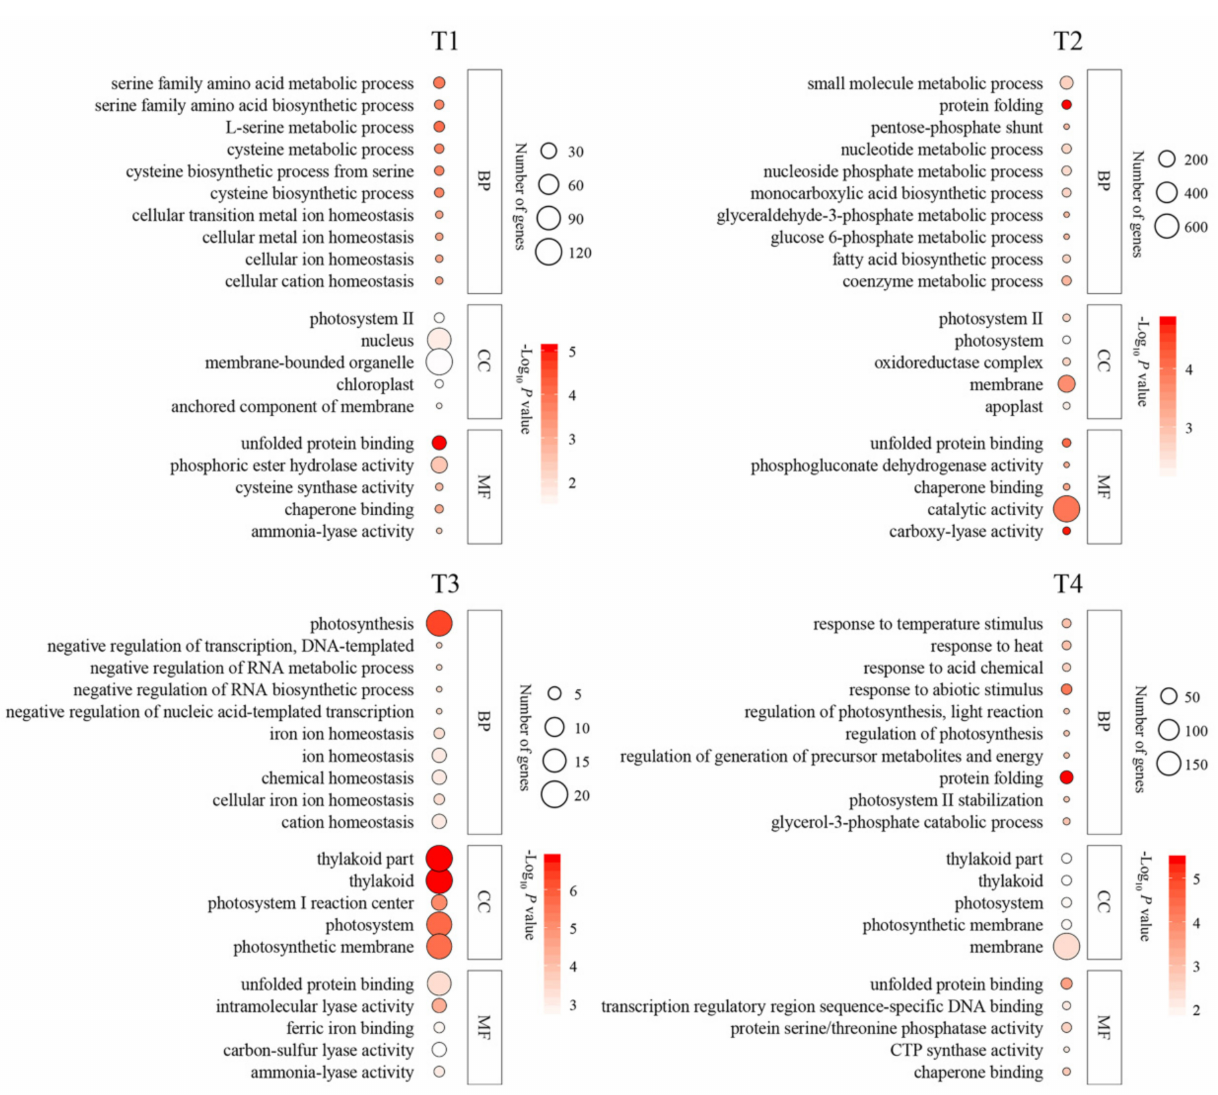
Figure 3. Gene Ontology (GO) enrichment analysis of differentially expressed genes (DEGs) in the apple in the comparisons of 35 ◦ C vs. 25 ◦ C at T1, T2, T3, and T4. The DEGs were presented in three main types, respectively, ‘biological process’, ‘cellular component’, and ‘molecular function’. T1, T2, T3, and T4 represent apples after 3, 6, 9, and 12 days of 25 ◦ C and 35 ◦ C treatment,